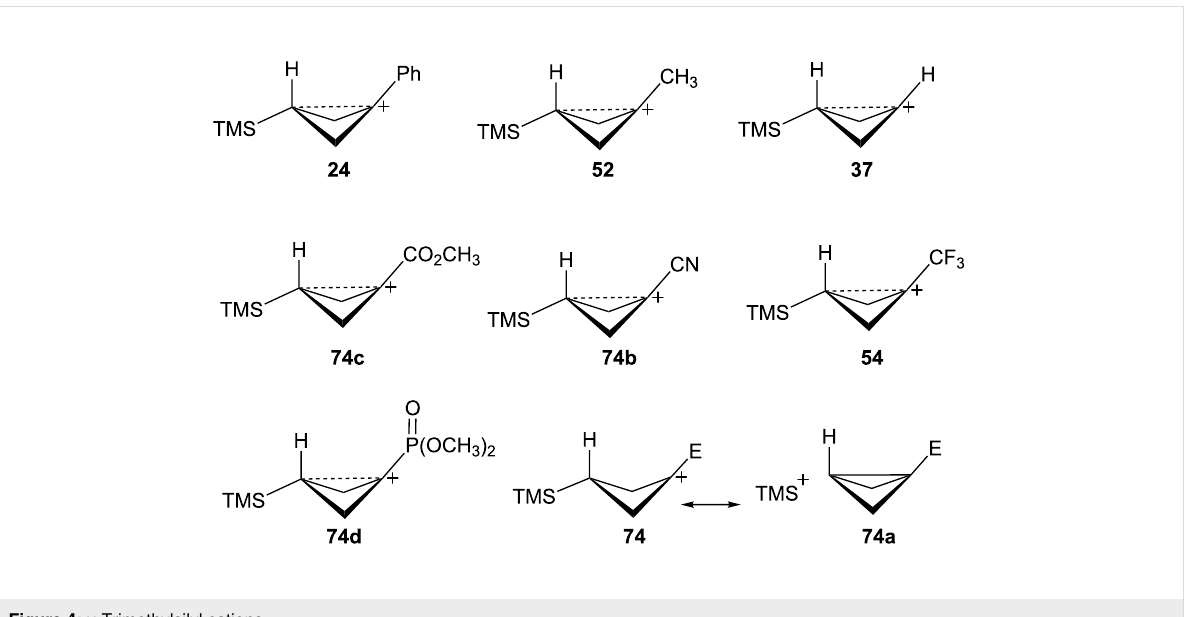
Figure 4: γ -Trimethylsilyl cations.